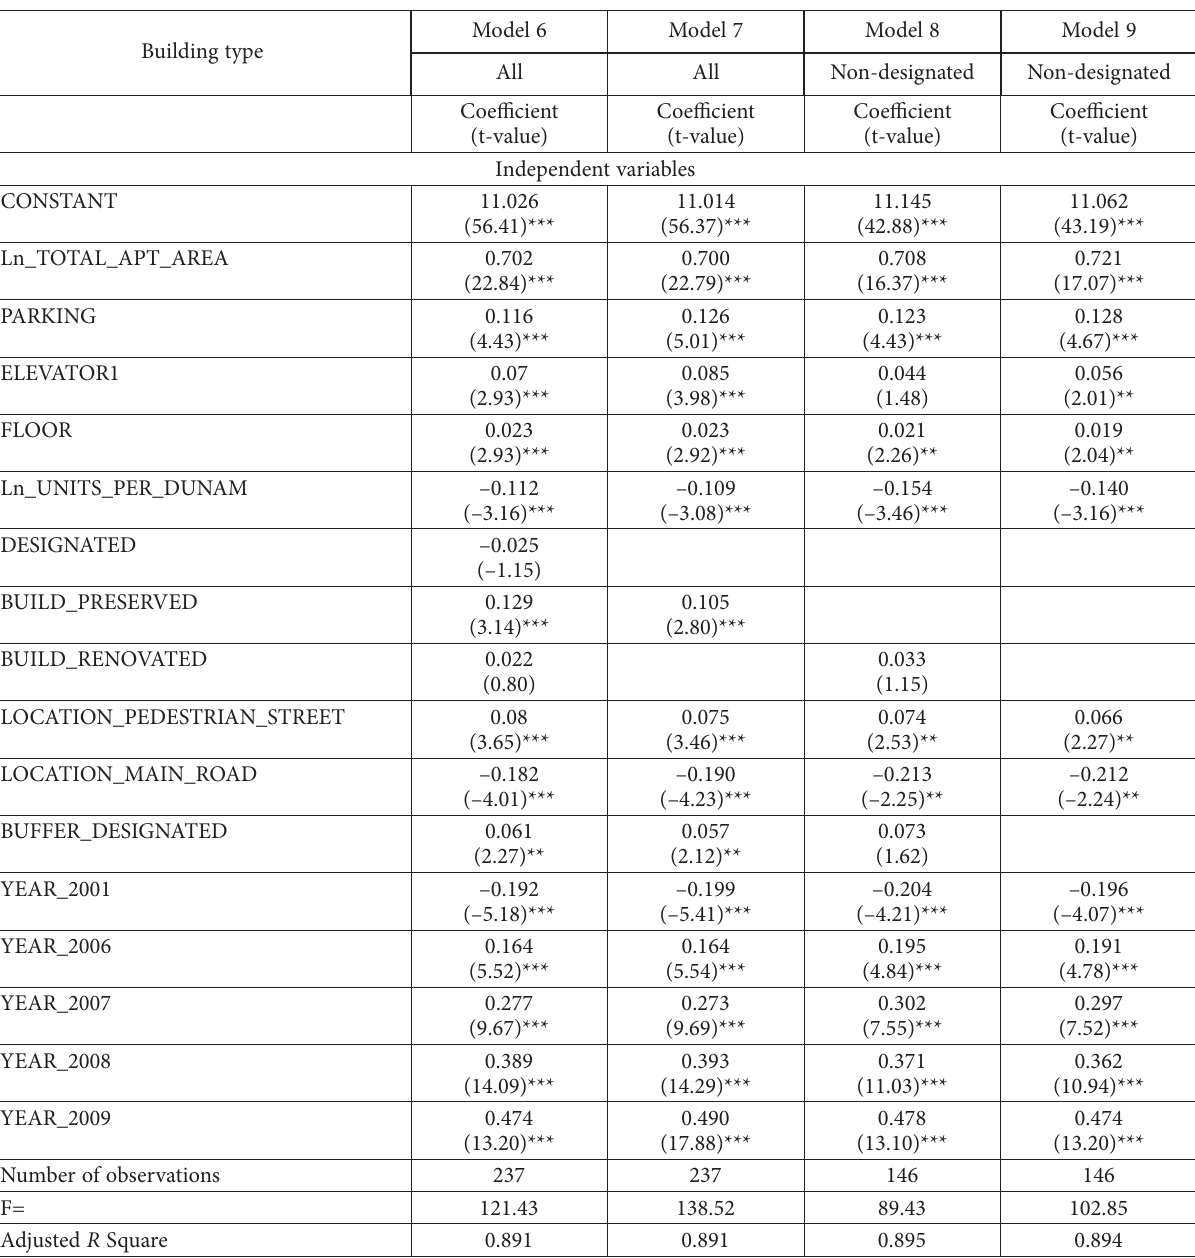
Table 4. Estimated coefficients for apartment